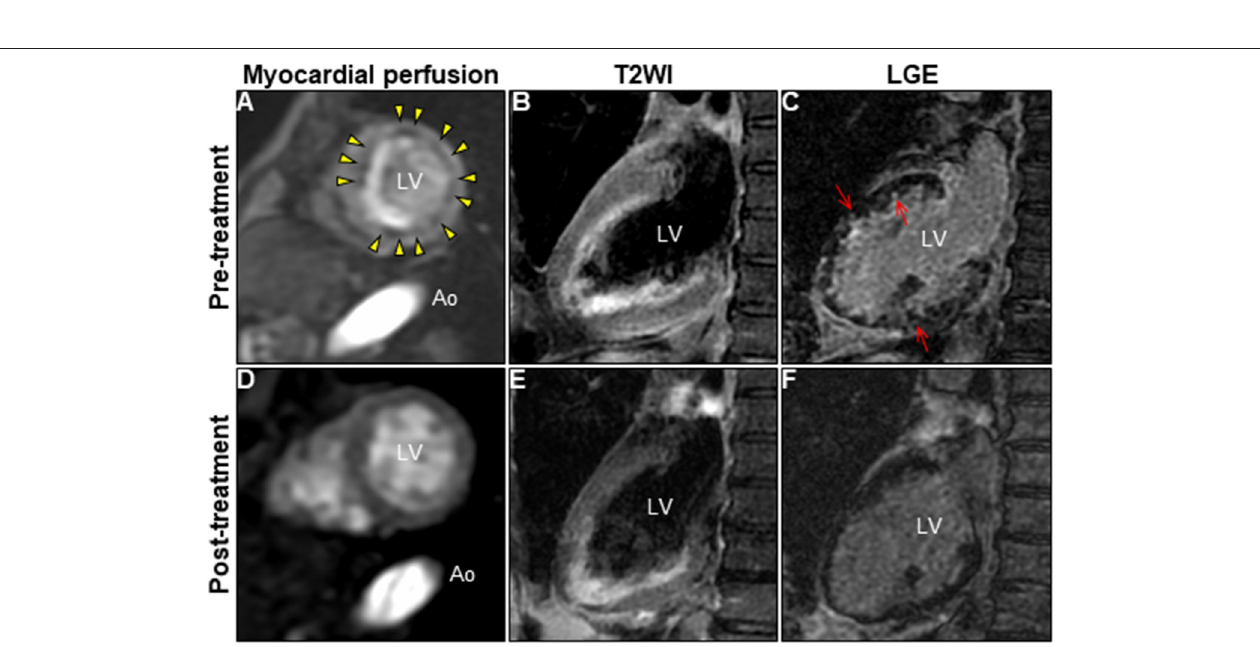
FIGURE 2 | Changes in CMR findings in patients following corticosteroid treatment. CMR findings before (A–C) and after corticosteroid treatment (D–F) . Myocardial first-pass perfusion imaging at rest (A,D) , T2WI of the 2-chamber view (B,E) , and LGE image (C,F) . Ao, aorta; CMR, cardiac magnetic resonance; LGE, late gadolinium enhancement; LV, left ventricle; T2WI, T2-weighted image.